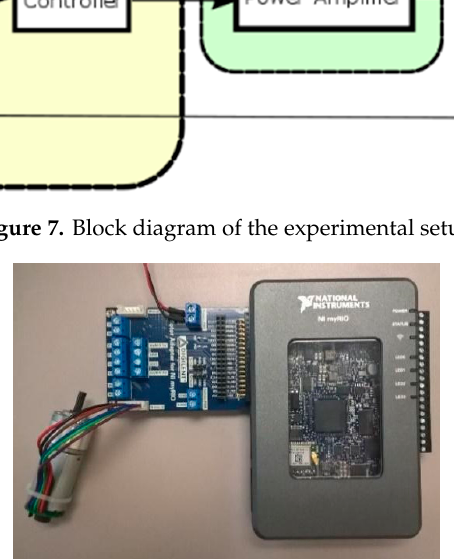
Figure 8. MyRIO system with a motor adapter and a DC motor used in undergraduate engineering control systems classes.